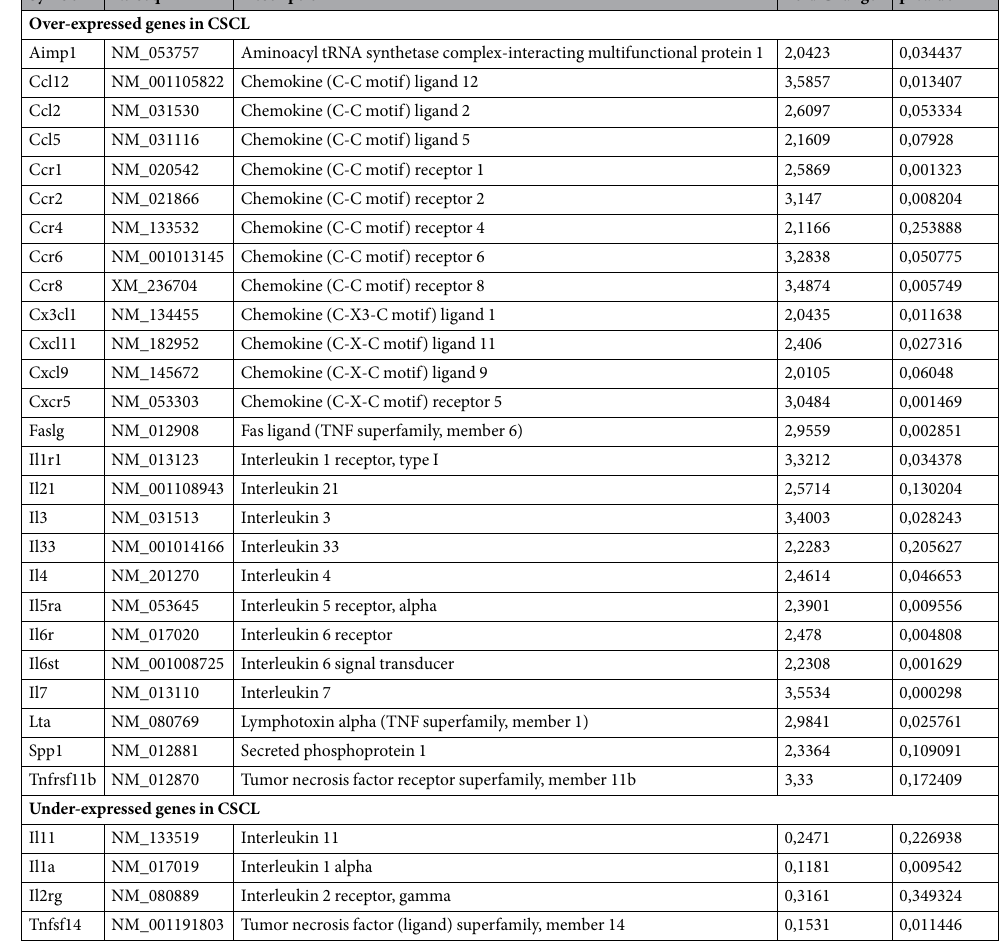
Table 1. Over- and under-expressed genes in 24 h CSCL in vivo implant compared with CL profiled on pro- inflammatory cytokines and receptors PCR